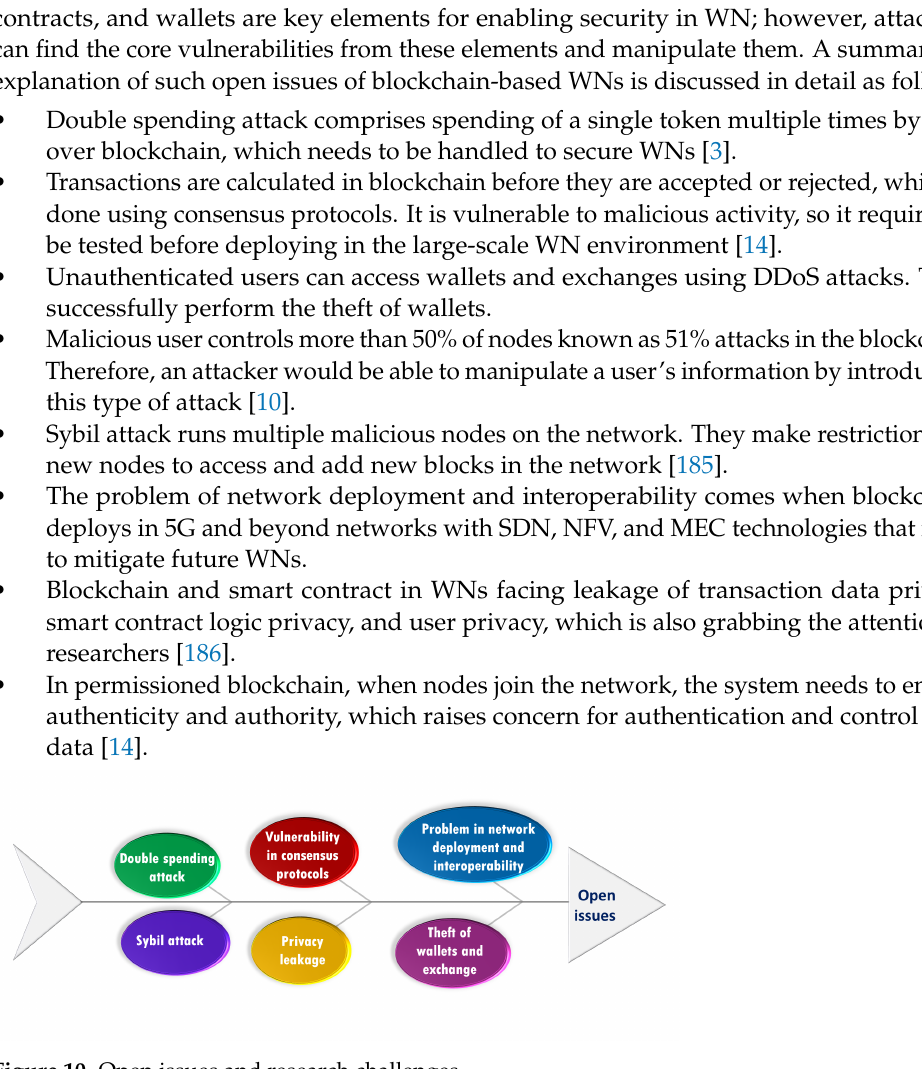
Figure 10. Open issues and research